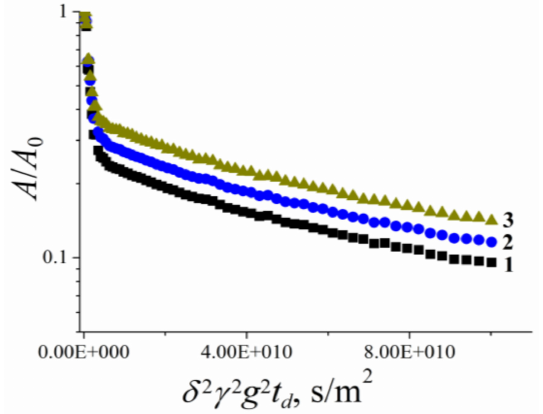
Figure 65. Diffusion decays of the 1 H spin echo–signal from different regions of integration: (1) 0–3.7 ppm, (2) 0–3 ppm, (3) 0–2 ppm. Diffusion time t d = 50 ms. Temperature is 35 ◦